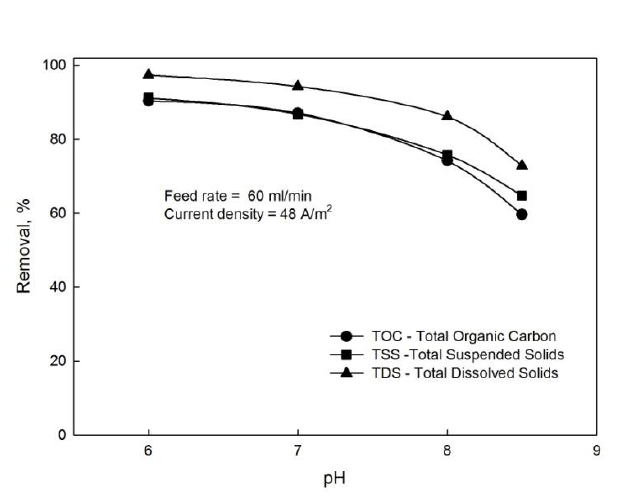
Figure 6. Effect of pH on removal efficiency.